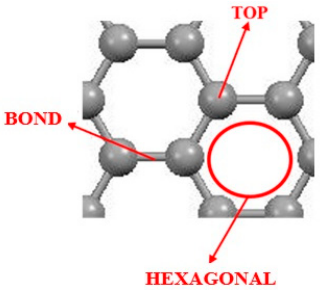
Figure 6. Top, bond, and hexagonal adsorption sites of Ni on the graphene sheet surface.